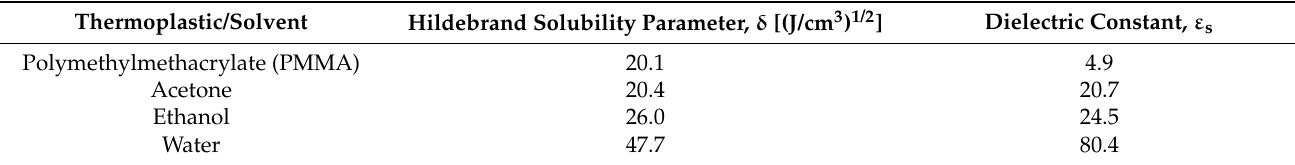
Table 1. Solubility and dielectric constant of PMMA and organic solvents [14].